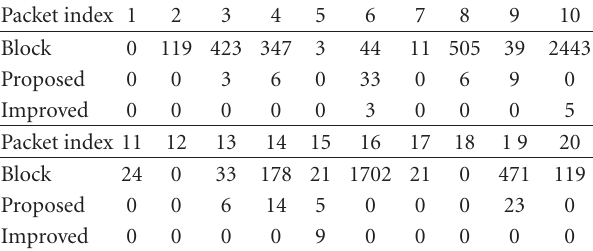
Table 2: Performance of the experimental results between the improved and block-based Doppler shift techniques for N c = 1024.